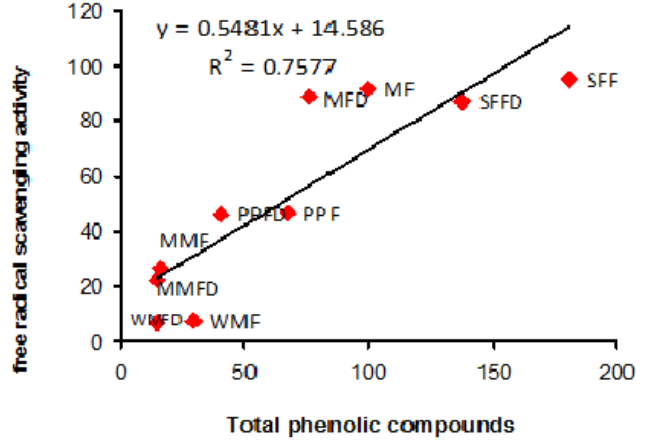
Figure 5. Correlation between ferric reducing antioxidant activity and total phenolic compounds of selected fruits.SFFD: starfruit freeze-dried; SFF: starfruit